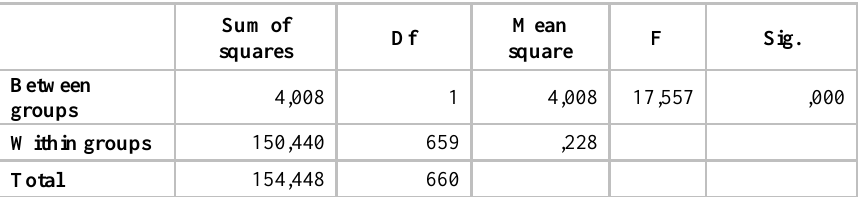
Table 2. Shopper approach